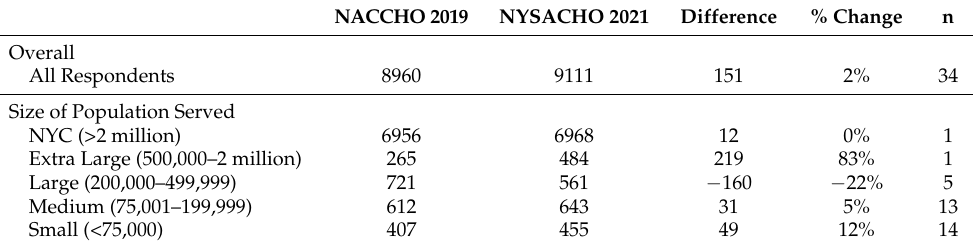
Figure 1. Occupational-Title Composition of the LHD Workforce in NYS (2021). Inverse probability weighting is applied to adjust for nonparticipation. Table 3. Total FTEs Employed in LHDs, NYS (2019 vs.